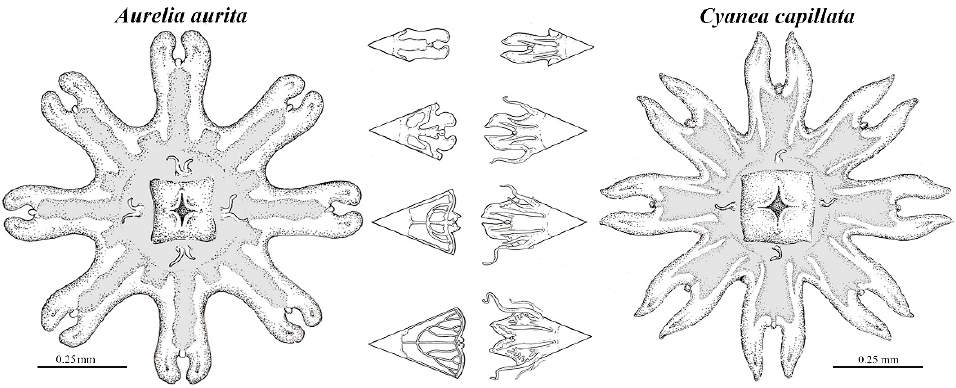
Figure 5. Morphological characteristics of Scyphozoan ephyra A. aurita (left) and C. capillata (right) with gradual change in lappet morphology during growth. Image credit: N. Bezio.